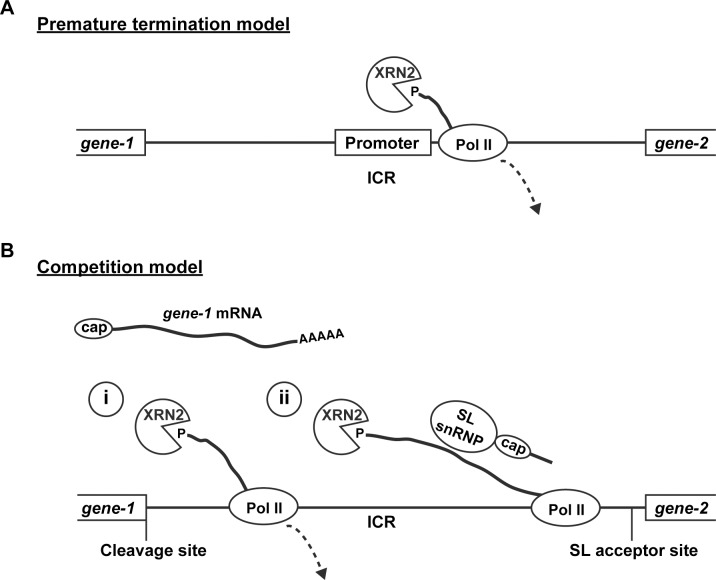
Mechanistic models for polycistronic gene regulation by XRN2.XRN2-mediated polycistronic gene regulation occurs through an (A) operon promoter-independent and (B) an operon-promoter-dependent mechanism. (A) Premature termination model. XRN2 degrades uncapped or decapped nascent RNA transcripts from a promoter in the ICR and terminates transcription at promoter proximal site. (B) Competition model. Following 3’ end cleavage of the upstream gene, XRN2 degrades the downstream fragment. Competition with (i) ongoing transcription by RNA pol II, whose activity XRN2 can terminate, or (ii) capping by trans-splicing determines production of xrn-2 mRNA. SL indicates SL1 or SL2.